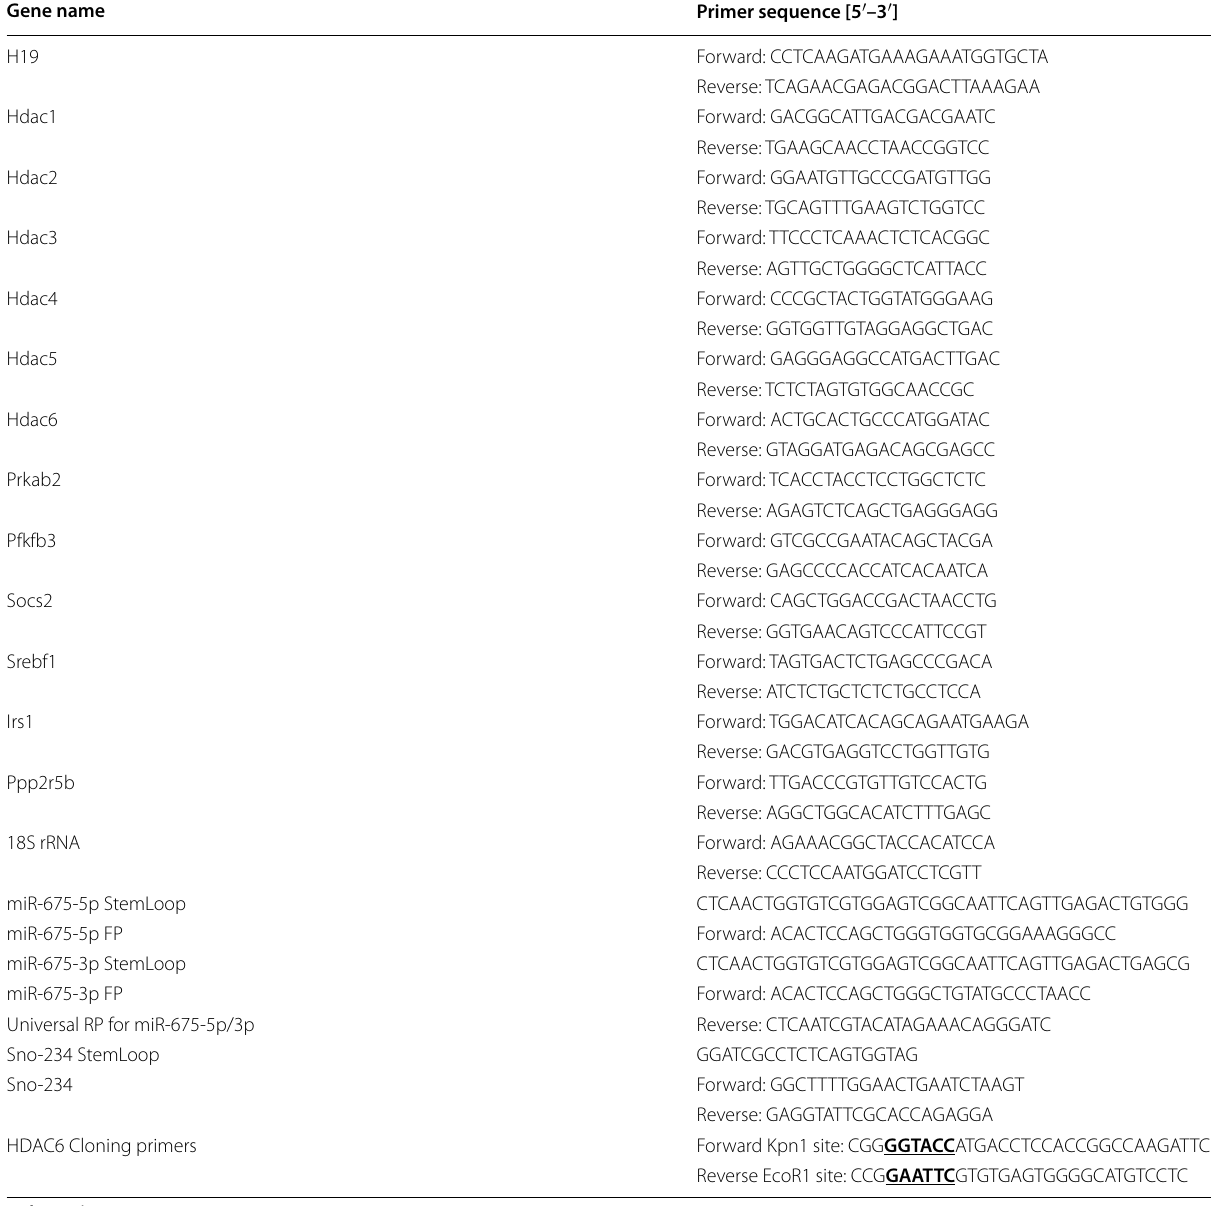
Table 1 Primer sequences used for qRT-PCR and